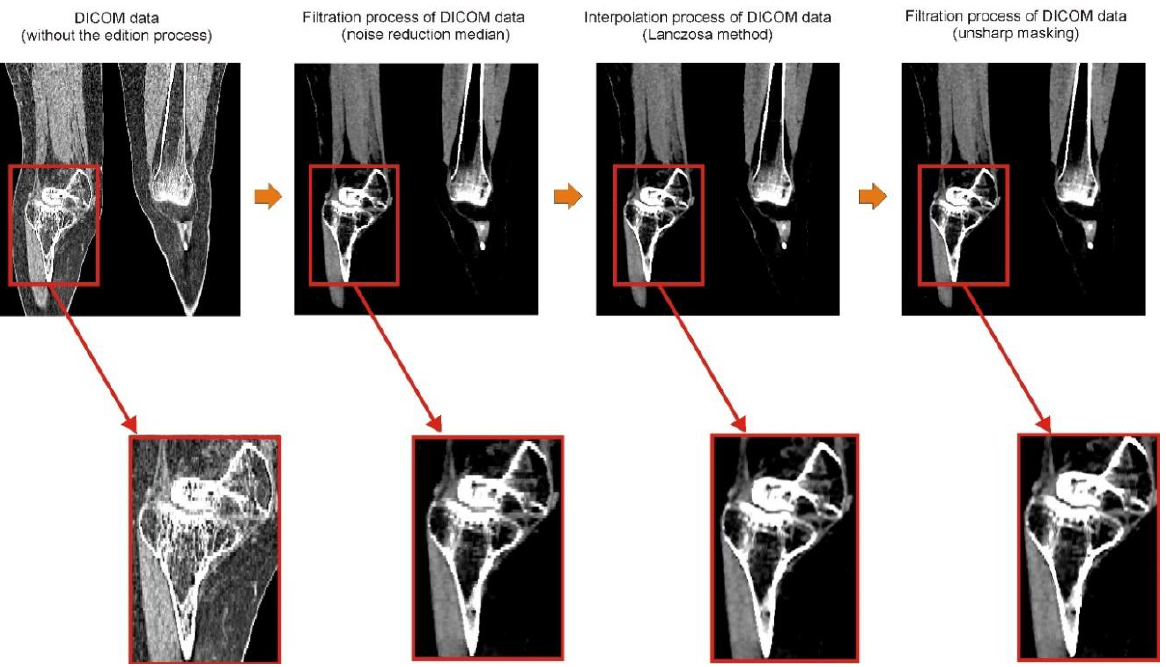
Figure 5. Digital filtration process and data interpolation improving the diagnostic quality of the DICOM data within the area of the knee joint at the stage of the design process.